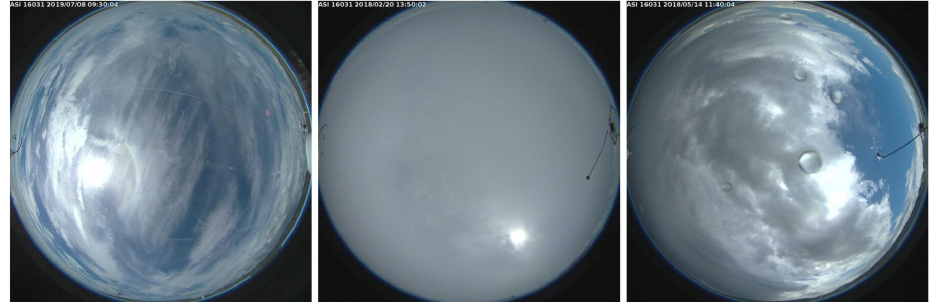
Figure 1. Ground-based cloud